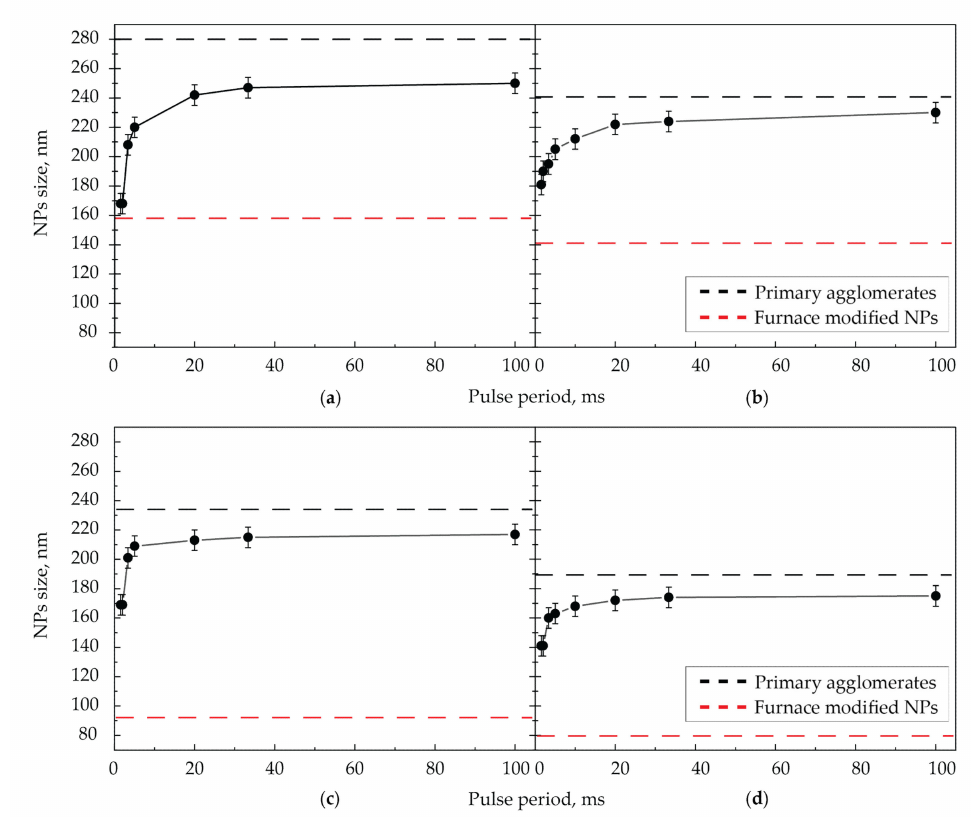
Figure 8. Dependencies of NPs size at the output of the cell on the pulse repetition period of laser radiation with the wavelength of 527 nm at the maximum pulse energy of 180 µ J and the gas flow rates of ( a ) 50, ( b ) 100, ( c ) 200, and ( d ) 400 mL/min. The solid black curves position (the size of laser-modified NPs) under the dashed black lines (the size of initial agglomerates) indicates that the sintering of NPs by laser radiation occurred in all cases. For all values of the aerosol flow in the graphs, as the pulse repetition period increases, a sharp increase in size is initially observed, and then, starting from the pulse repetition period of 10 ms, the NPs size increases slightly. In addition, with an increase in the aerosol flow at the same pulse repetition rates, the modification efficiency